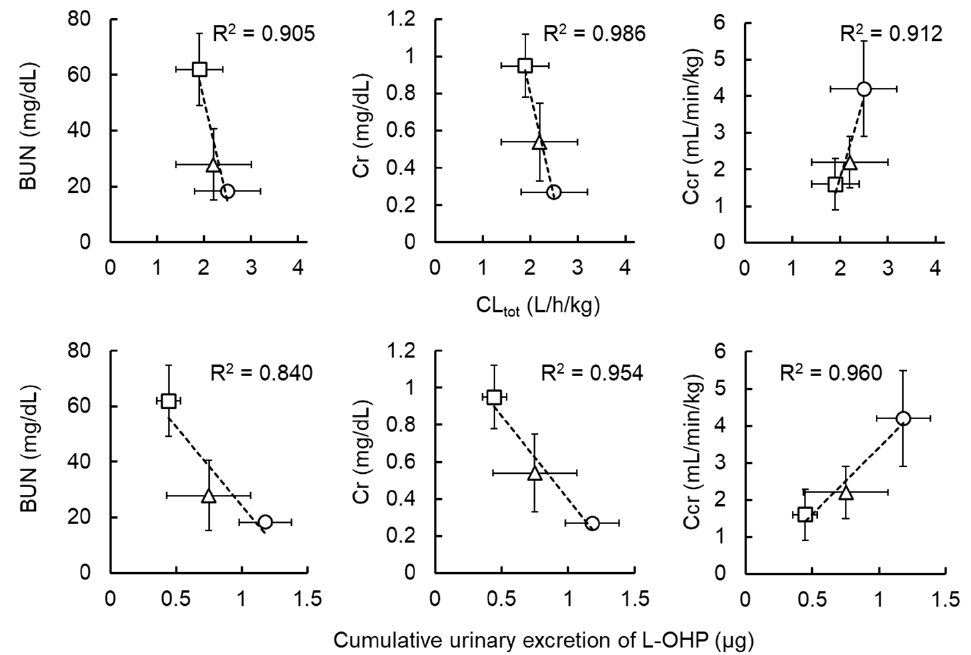
Figure 3. Correlation between biochemical parameters (blood urea nitrogen (BUN), creatinine (Cr), creatinine clearance (C Cr )), and pharmacokinetic parameters of oxaliplatin (L-OHP) (total clearance (CL tot ) and cumulative urinary excretion of L-OHP for 4 h). Each symbol represents normal ( ○ ), mild ( △ ), or severe renal dysfunction ( □ ) groups. Each point shows the mean ± S.D. ( n = 3–5).